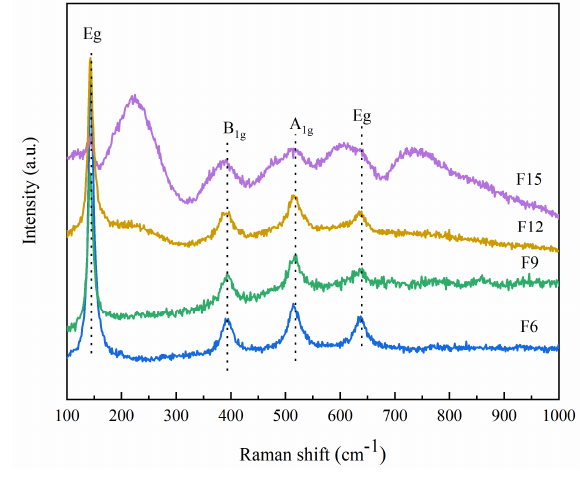
Figure 3. Raman patterns of samples.